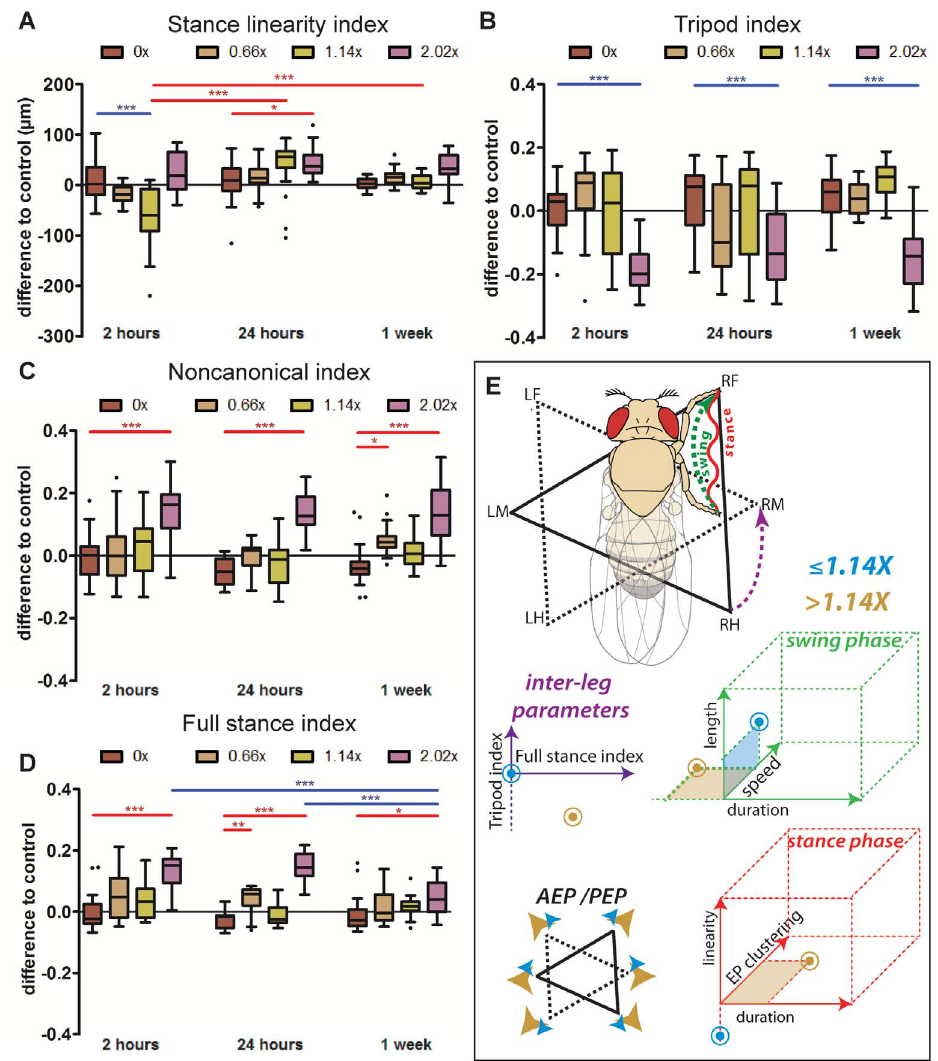
Figure 6. Stance linearity, interleg coordination parameters and summary of kinematic effects under different load conditions. (A– D) Box plots represent the median as the middle line, with the lower and upper edges of the boxes representing the 25% and 75% quartiles, respectively; the whiskers represent the range of the full data set, excluding outliers. Circles indicate outliers. Statistical significance was determined using 2-way-ANOVA with post-hoc t-tests, where * p , 0.05; ** p , 0.01; *** p , 0.001. Statistically significant increases or decreases are indicated in red and blue, respectively. (A) Stance Linearity Index. Flies bearing intermediate weights show less wobble during stance phases compared to controls at 2 hours, while flies bearing the heaviest loads display more wobble at all time points. (B) Tripod Index. Flies bearing 2.02 6 weights show significantly reduced tripod index at all three time points. (C) Non-canonical Index is markedly increased for flies bearing 2.02 6 weights. (D) Full Stance Index is increased for 2.02 6 bearing flies at all time points. (E) Summary of kinematic affects due to load bearing. For simplicity, only the step cycle of the right foreleg is represented. Dashed green line represents the swing phase from PEP to AEP. Waved red line represents stance traces. Solid triangle represents the tripod conformation formed by RF, LM and RH. Dashed triangle represents the immediately subsequent tripod conformation. Purple dashed line represents the transition between the two tripod conformations. Blue points represent the qualitative effects transiently observed for animals carrying 1.14 6 or lighter weights, while brown points represent the effects observed for walking animals carrying 2.02 6 weights.